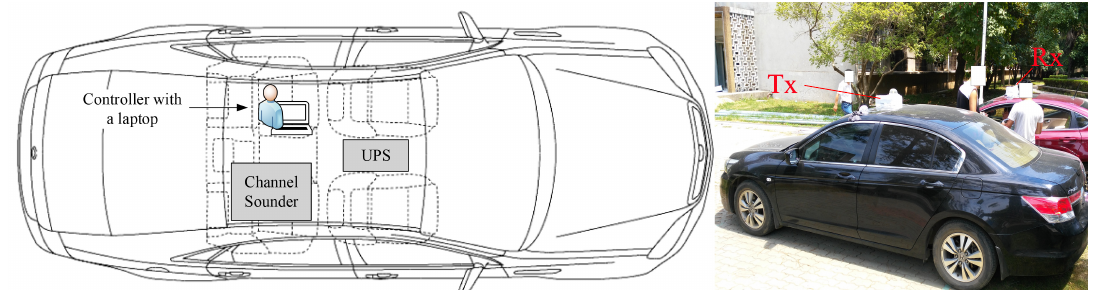
Figure 3. Example of the installation for the measurement campaigns.